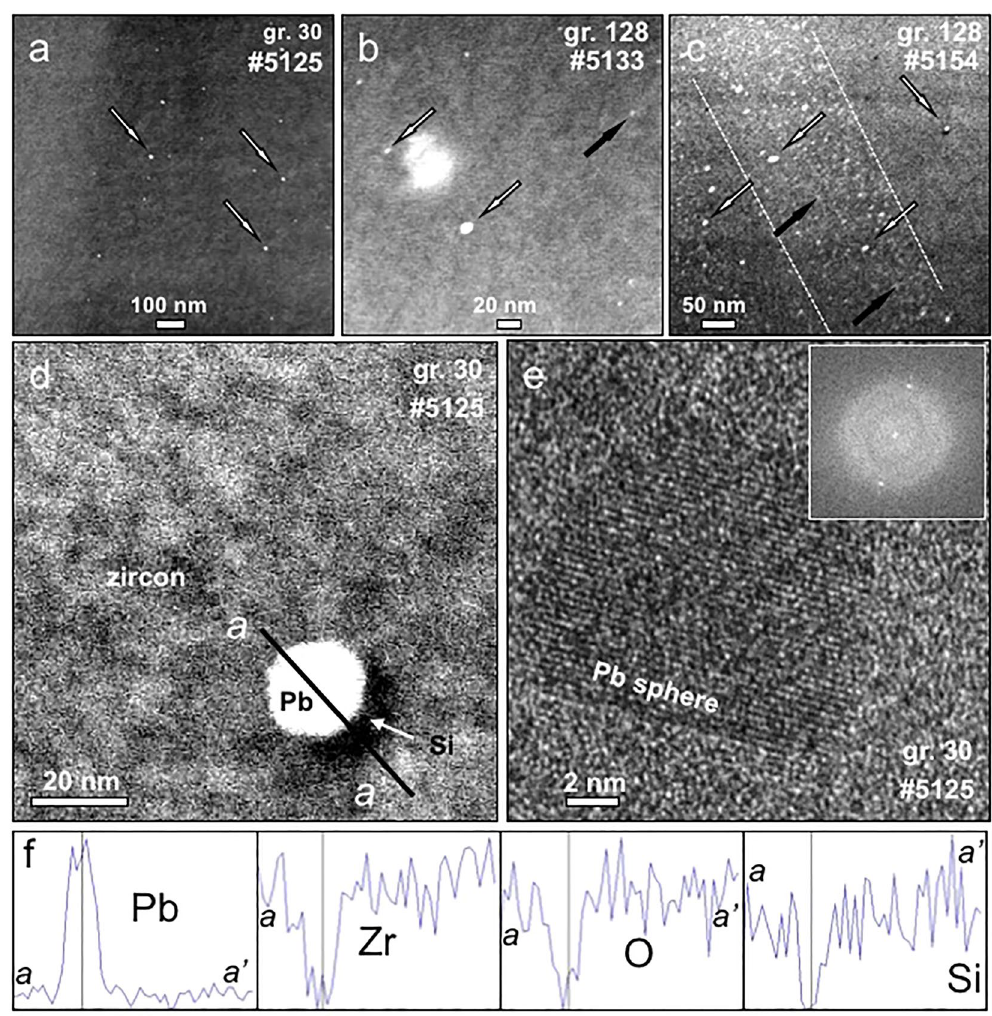
Figure 2. Images showing the distribution and nature of the lead (Pb) nanospheres in zircons of Groups 3 and 5 from Jack Hills where they are most abundant. ( a ) Random distribution of Pb nanospheres (white spots, with some marked by white arrows) in HAADF image of foil #5125 from grain 30 of Group 5 ; ( b ) HAADF image of foil #5133 showing scattered Pb nanospheres and Y nanoclusters (grey spots, with one marked by a black arrow) in grain 128 from Group 3 ; ( c ) HAADF image of foil #5154 from grain 128 of Group 3 showing a 150 nm-wide zone of Y enrichment (within white dashed lines). Note that Pb nanospheres are also present, but they are randomly distributed through the image and not concentrated in the Y-rich zone; Pb nanospheres— white arrows: Y nanoclusters—black arrows; ( d ) enlarged HAADF image of foil #5125 from grain 30 of Group 5 showing detail of Pb nanosphere with partial Si-rich rim (black); black line a–a 1 marks the profiles shown in ( f ); ( e ) HREM image of foil #5125 from grain 30 of Group 5 showing Pb nanosphere with diffraction pattern (inset top right corner) confirming cubic symmetry; ( f ) EDS spectra of Pb, Zr, O and Si along profile a–a ’ in ( d